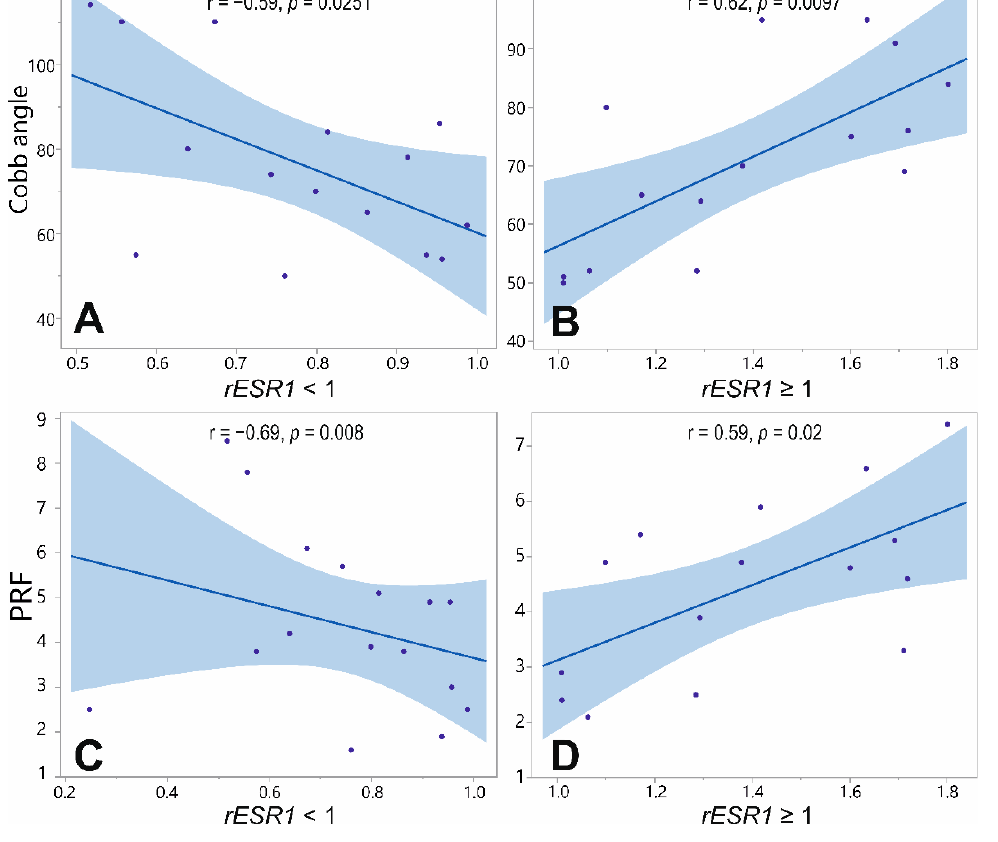
Figure 3. Correlation between ratio (convex to concave) of ESR1 gene expression level ( rESR1 ) in deep paravertebral and phenotype parameters. ( A ). Correlation between the rESR1 and the value of the Cobb angle in patients with rESR1 < 1. ( B ). Correlation between the rESR1 and the value of the Cobb angle in patients with rESR1 > 1. ( C ). Correlation between the rESR1 and the value of the risk of progression factor (PRF) in patients with rESR1 < 1. ( D ). Correlation between the rESR1 and the value of the PRF in patients with rESR1 > 1. Linear fit lines and 95% confidence intervals are shown in blue.